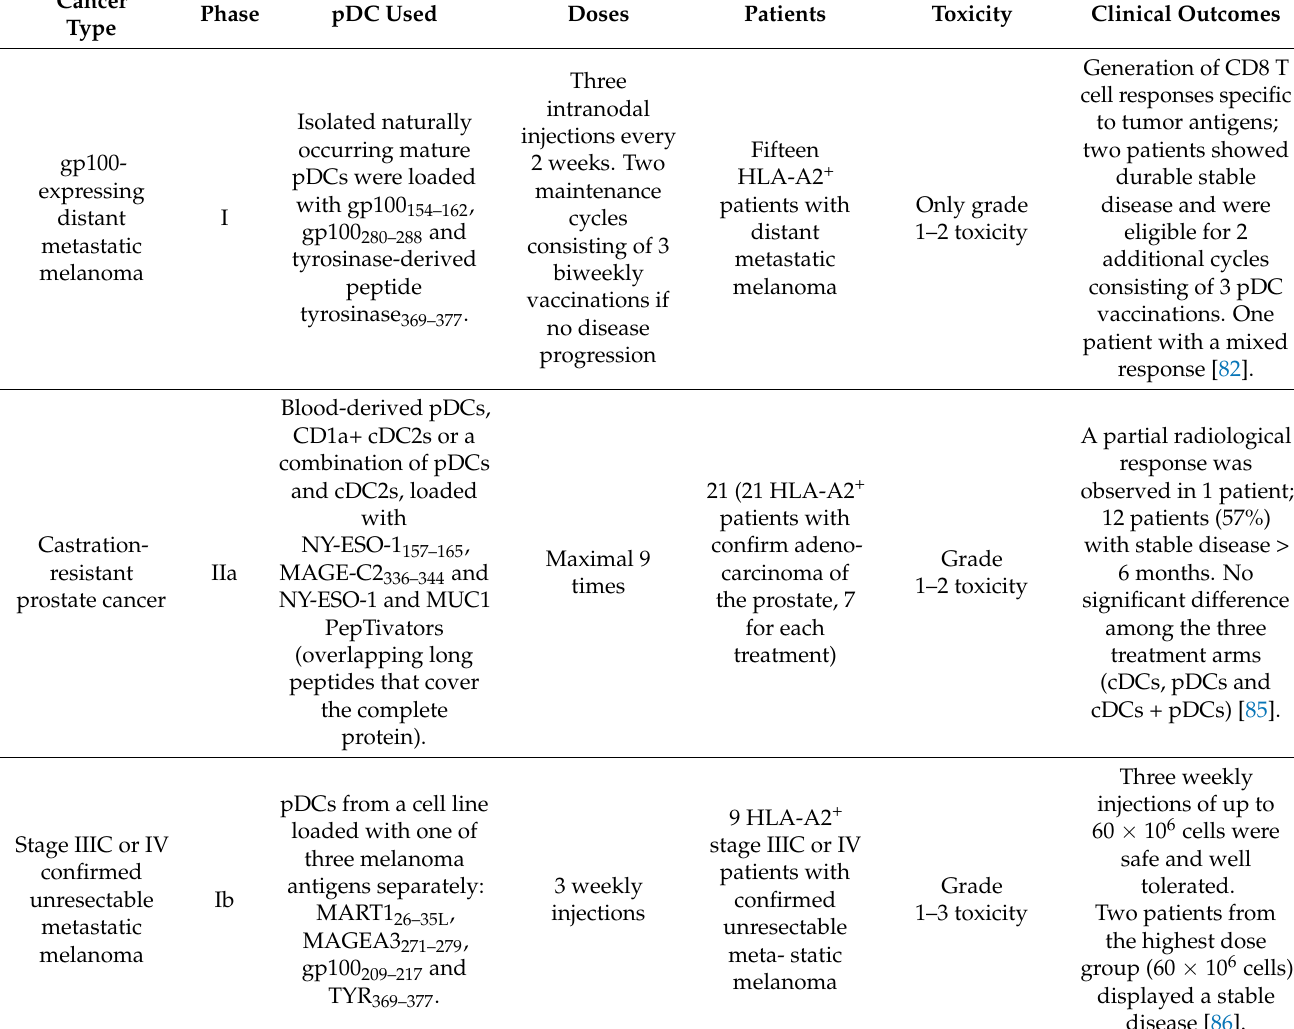
Table 2. Current pDC-based clinical